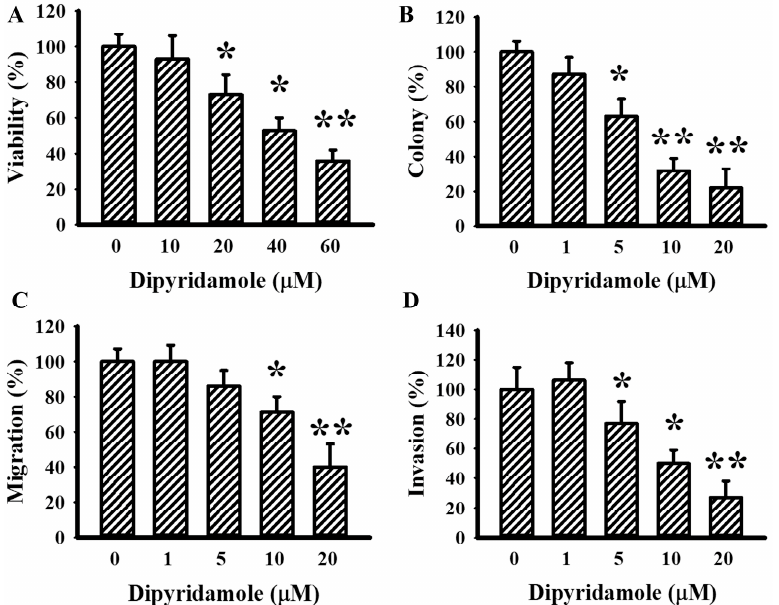
Figure 1. Dipyridamole decreased cell viability in U87 cells. U87 cells were treated with various concentrations of dipyridamole, as indicated. ( A ) Cell viability (24 h) was determined using MTS reduction assay. ( B ) Colony numbers (6 days) were visualized and counted. Cell migration (24 h) ( C ) and invasion (24 h) ( D ) were measured using a Transwell apparatus in the absence or presence of matrigel. * p < 0.05 and ** p < 0.01 vs. untreated control, n = 4.